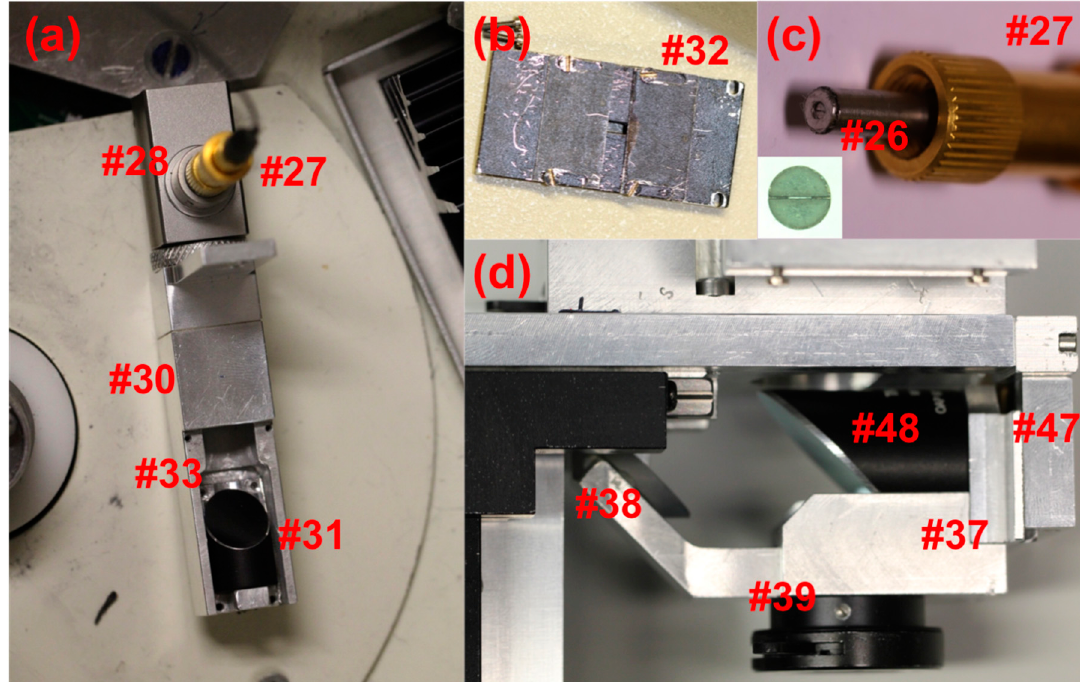
Figure 4. ( a ) Illumination assembly: Adjustable SMA connector, illumination collimating off-axis parabolic mirror (OAPM), illumination focusing OAPM, and focusing OAPM adjustment screws. ( b ) Illumination assembly adjustable aperture. ( c ) Fiber tip slit mask to be mounted on end of SMA connector. Inset showing close up of tip slit mask. ( d ) Lower imaging assembly: lower imaging OAPM, lower iris, and 90° flat mirror.